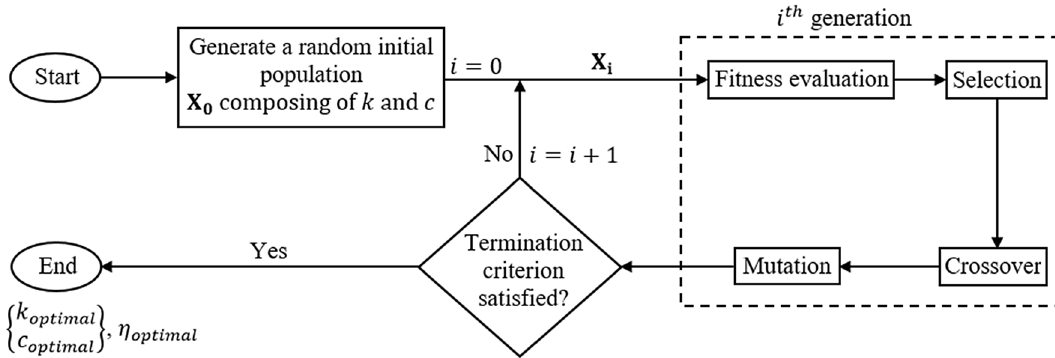
Figure 4. Flow chart of genetic algorithm-based optimization for control